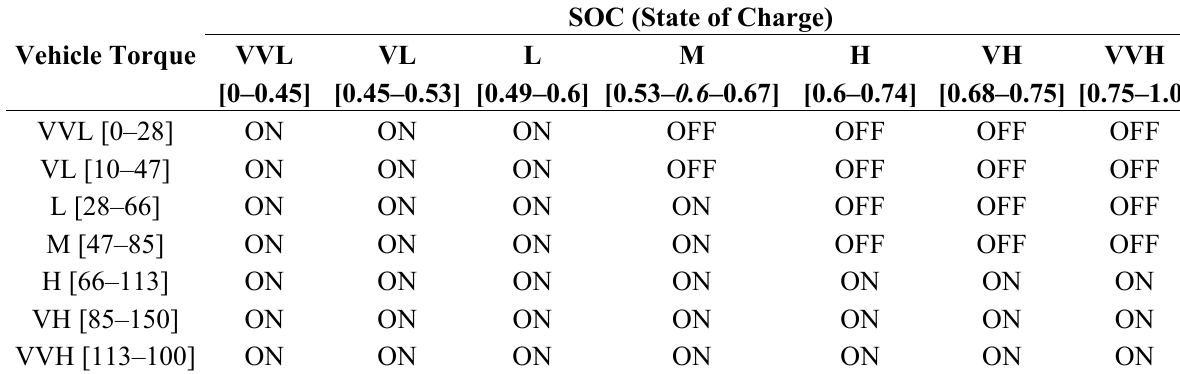
Table 1. Rule table for fuzzy logic ICE ON/OFF controller.